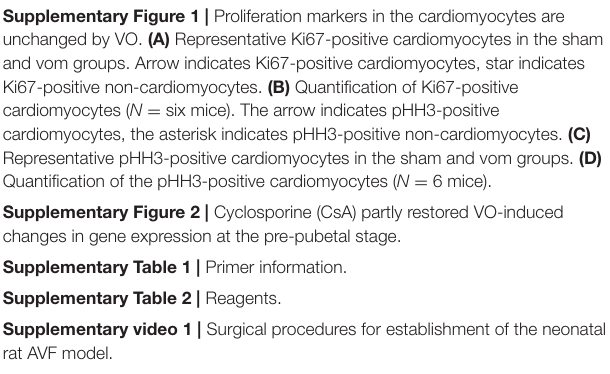
Supplementary Figure 1 | Proliferation markers in the cardiomyocytes are unchanged by VO. (A) Representative Ki67-positive cardiomyocytes in the sham and vom groups. Arrow indicates Ki67-positive cardiomyocytes, star indicates Ki67-positive non-cardiomyocytes. (B) Quantification of Ki67-positive cardiomyocytes ( N = six mice). The arrow indicates pHH3-positive cardiomyocytes, the asterisk indicates pHH3-positive non-cardiomyocytes. (C) Representative pHH3-positive cardiomyocytes in the sham and vom groups. (D) Quantification of the pHH3-positive cardiomyocytes ( N = 6 mice). Supplementary Figure 2 | Cyclosporine (CsA) partly restored VO-induced changes in gene expression at the pre-pubetal stage. Supplementary Table 1 | Primer information. Supplementary Table 2 | Reagents. Supplementary video 1 | Surgical procedures for establishment of the neonatal rat AVF